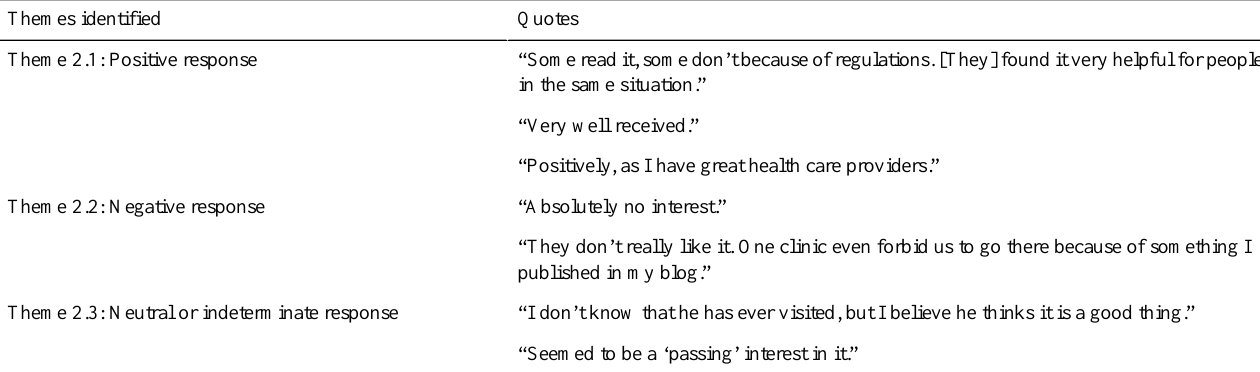
Table 4. Responses from health care providers upon knowing about the blog.